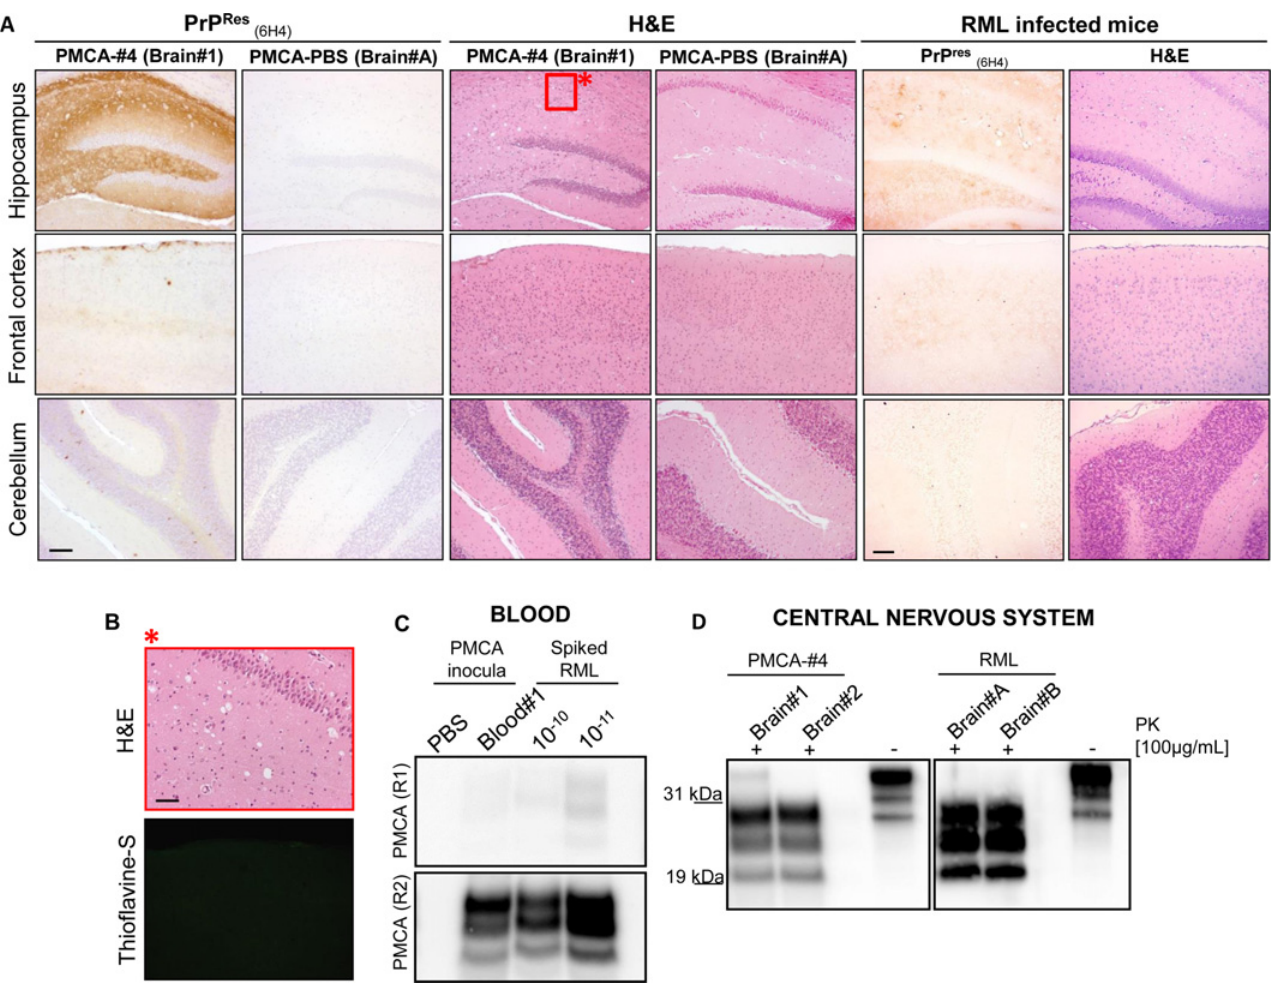
Fig 10. Detection of PMCA-#4 in brain and blood of infected animals and related immunohistochemical/biochemical characterization. Neuropathological analysis of PMCA-#4 and PMCA-PBS injected animals and comparison to that of RML infected mice. Animals injected with PMCA-#4 showed widespread deposition of PrP Res in the hippocampus with focal plaque-like deposits found in the cerebral cortex. Cerebellum is completely spared by PrP Res accumulation. RML injected animals showed the typical pattern of widespread, synaptic and diffuse PrP Res accumulation in the whole brain with major involvement of thalamus and hippocampus. Spongiform changes were mainly found in the hippocampus of PMCA-#4 injected animals. Few vacuoles were detected in the cerebral cortex, while cerebellum did not show any vacuolation. RML injected animals showed severe vacuolation in the thalamus and hippocampus. Mild alterations were found in cerebellum and septum. Brain of PMCA-PBS injected animal was used as control (A). Higher magnification of the red square in panel A (see asterisk) and Thioflavin-S staining showing the lack of amyloid properties of the deposits found in the submeningeal level of the cerebral cortex (B). PMCA of blood collected at 140 day post infection (d.p.i.) from a symptomatic animal injected with PMCA-#4. RML dilutions (10 − 10 and 10 − 11 ) were used in PMCA to estimate the concentration of circulating infectious PrP (C). Biochemical analysis of the brains harvested from the first two animals injected with PMCA-#4 (sacrificed at terminal stage of the disease) were performed and compared to that of RML injected mice (D). Scale bar in A is 10 μ m; scale bar in B is 5 μ m. Western blots were performed using 6D11 monoclonal antibody to PrP (0.2 μ g/mL, Covance). Blots were developed with the enhanced chemiluminescent system (ECL, Amersham Biosciences) and visualized using a G:BOX Chemi Syngene